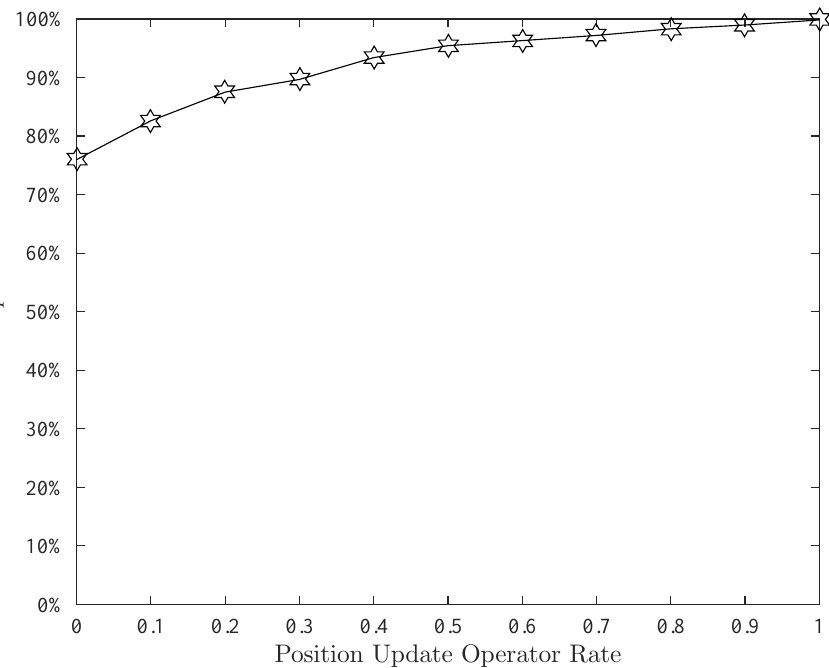
Figure 19. Effect of the position update operator